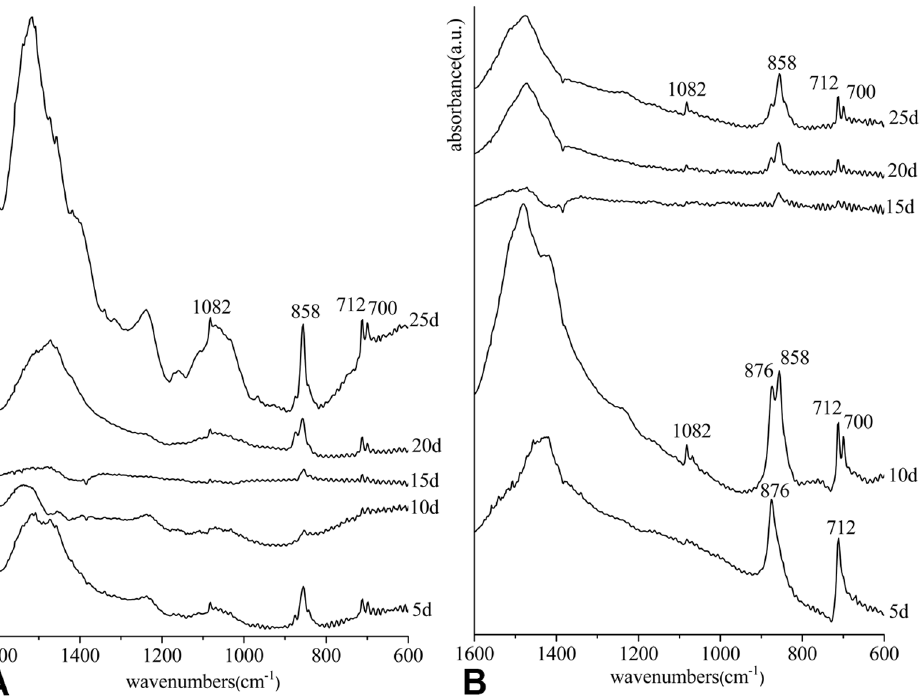
Figure 3. FTIR spectra of the crystals collected from the surface. (A) in the inner-shell film system, (B) in the film-free system. The characteristic bands of calcite are at 712 and 876 cm 2 1 (5d in B), and those of aragonite are at 700, 712, 858 and 1082 cm 2 1 . The mixture of calcite and aragonite is seen at 10d in B.